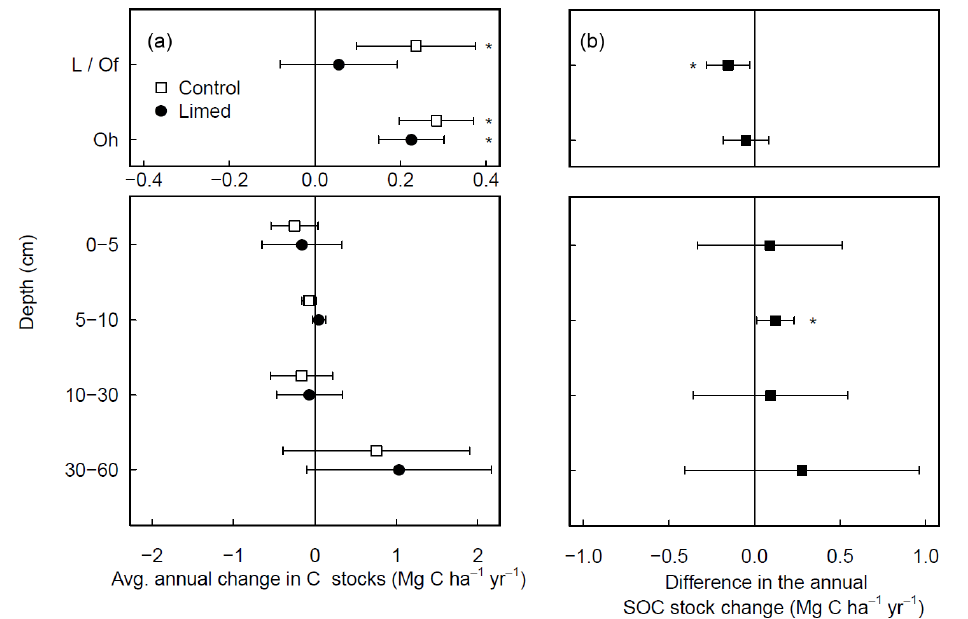
Figure 2. Average ( ± 95% T test confidence interval) annual changes in SOC stocks experienced over the last 2 decades in (a) both the control and limed plots and (b) the difference between the limed and control plots. Statistical significance was tested using LME models for each respective soil depth or layer at P ≤ 0 . 05